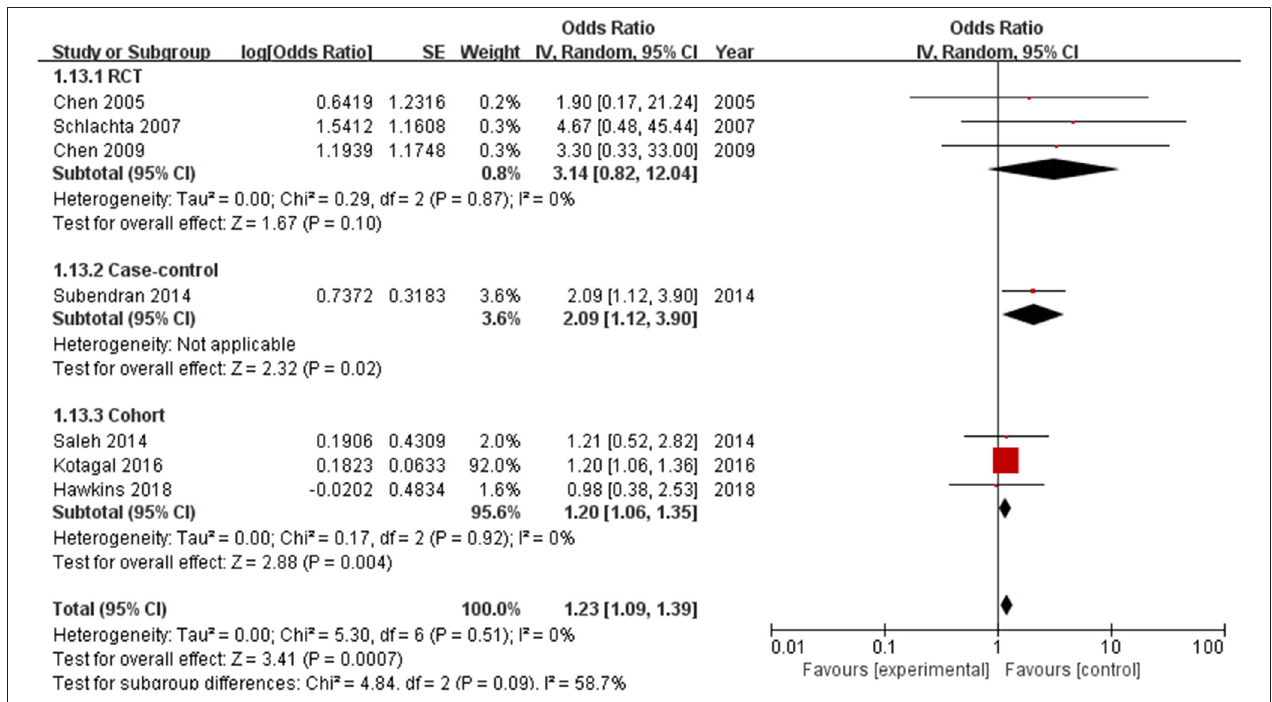
FIGURE 5 | Forest plots of subgroups according to different experimental study designs.